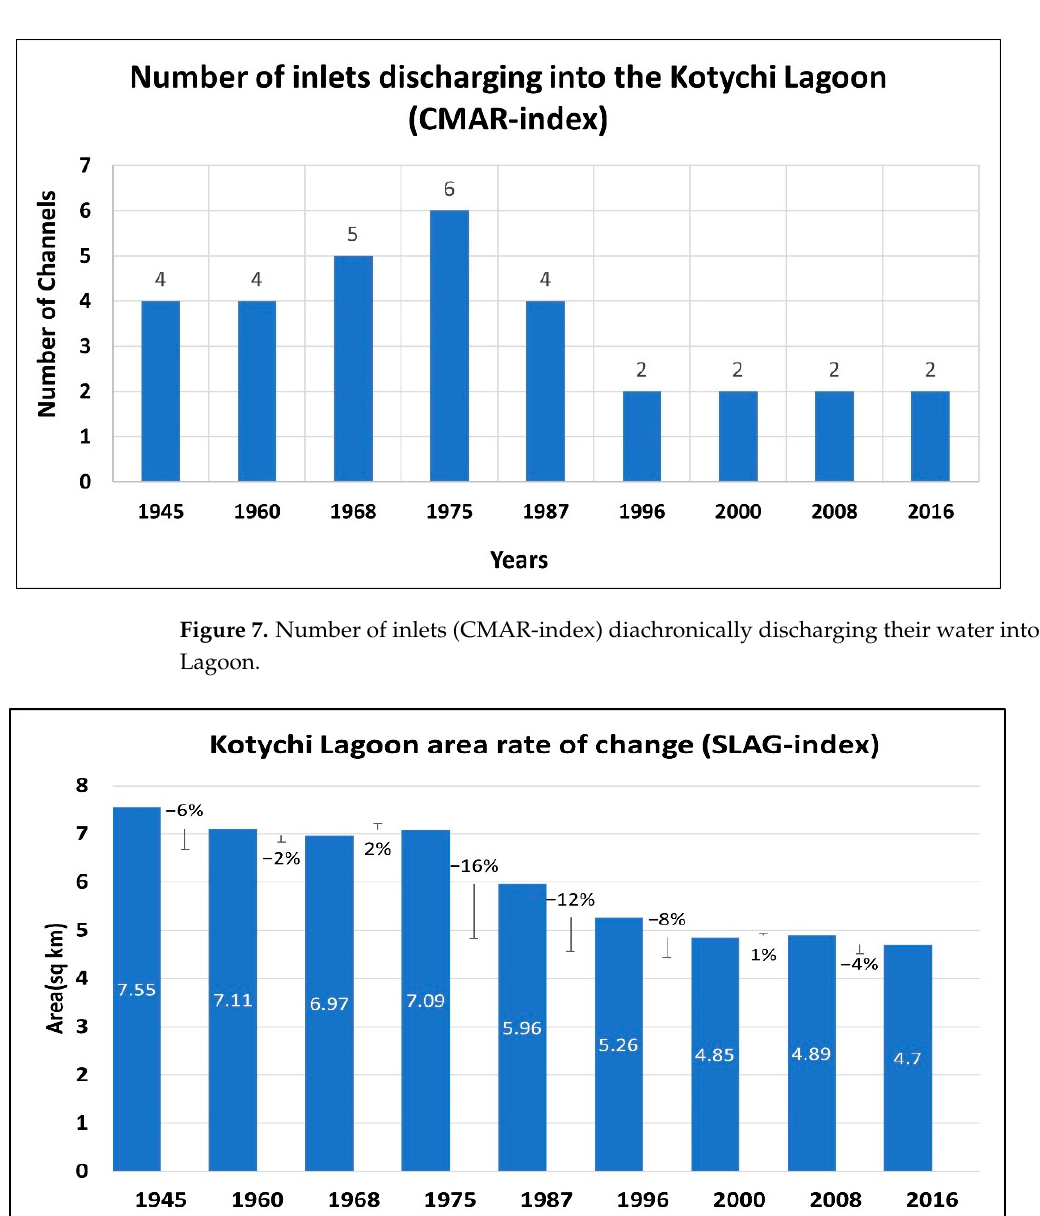
Figure 8. Water surface area fluctuations (%) during the study period in the Kotychi Lagoon.